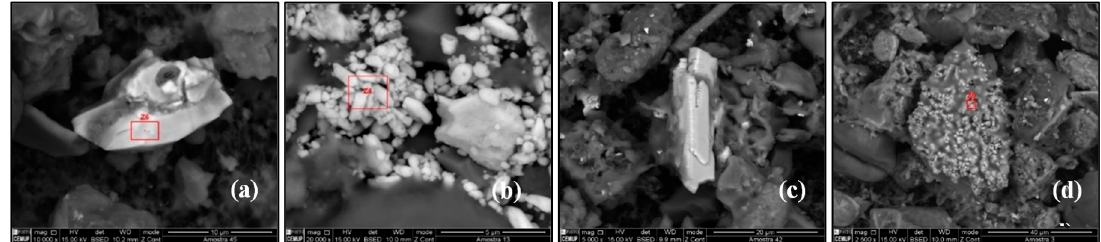
Figure 9. Scanning electron microscopy images of ( a ) zircon particles, ( b ) barium sulfate particles, ( c ) strontium sulfate particles, and ( d ) calcium carbonate particles.